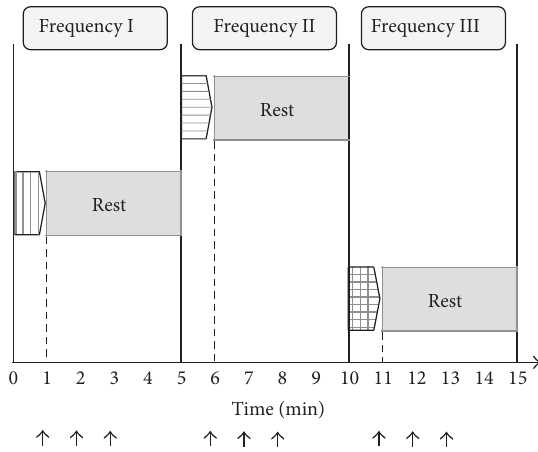
Figure 1: Protocol for active ankle movement at three frequencies and measurement of blood flow velocity at the profunda femoris. After one minute of active ankle movement, the velocity of venous blood flow was measured three times (black arrows indicate the point of measurement: (1) just after movement, (2) 1 minute after movement, and (3) 2 minutes after movement). The order of the three different frequencies (40, 60, and 80 contractions per minute) was determined by drawing lots. Four minutes after the first frequency of ankle movement, another frequency of active ankle movement was performed, and similar measurements were